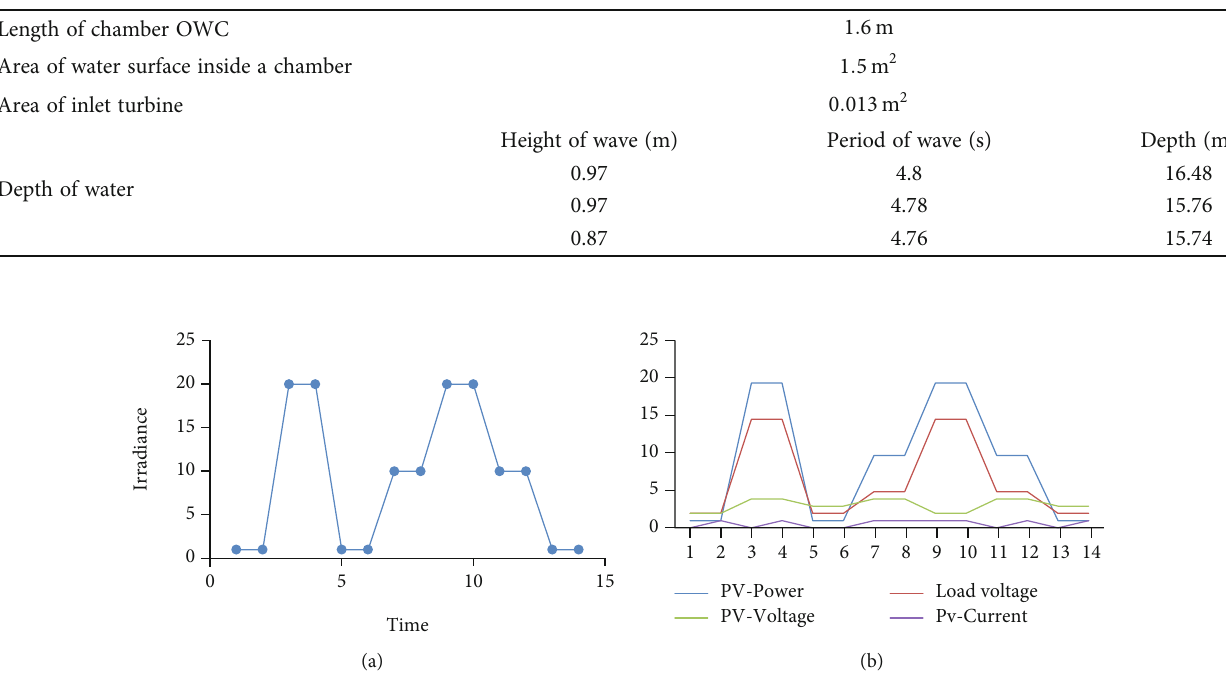
Table 3: OWC parameter.